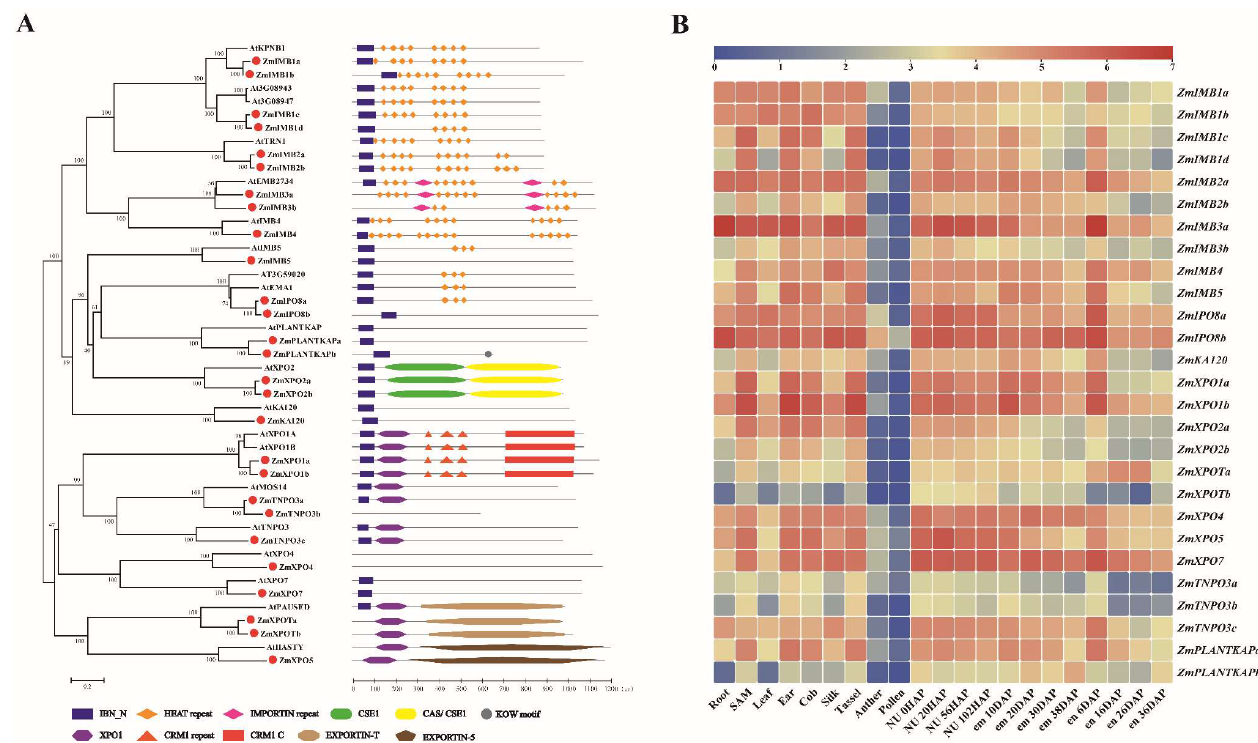
Figure 3. IMPORTIN β family in maize and Arabidopsis . ( A ) Schematic representation of the conserved domains between AtIMP β and ZmIMP β proteins according to Pfam Database and CCD Tools; ( B ) Heat map of the expression profile of ZmIMP β genes in different tissues, with the expression value calculated via log2 (FPKM). SAM: shoot apical meristem, NU: nucellus, em: embryo, en: endosperm, HAP: Hours after Pollination, DAP: Day after Pollination.